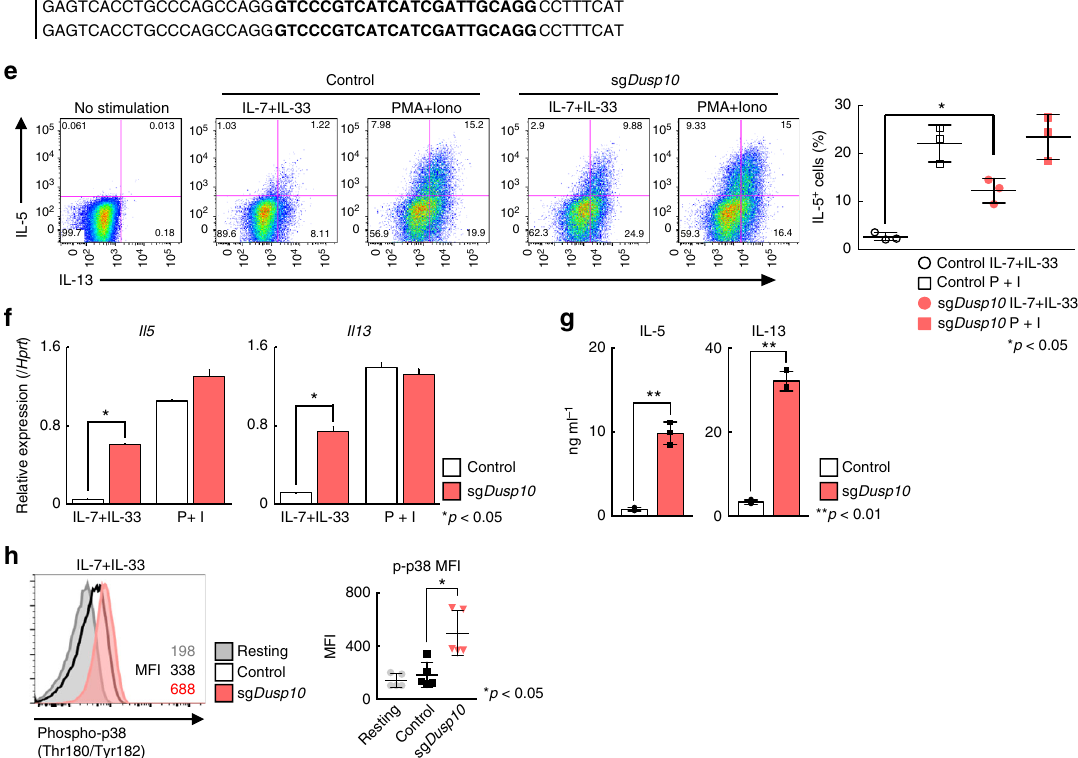
domain of DUSP10 abrogated its phosphatase activity, and (Fig. 4c, n = 3 for each group, * p < 0.05). Interestingly, the therefore we also included this mutant (C409S) form of DUSP10 Dusp10 C409S mutant did not affect cytokine production from in the assays 38 (Fig. 4a – c). We con fi rmed that the levels of cell ILC2s (Fig. 4c, far right). Similarly, mRNA expression of Il5 and surface and mRNA expression of Il1rl1 in ILC2s were not dra- Il13 in Dusp10 -overexpressing ILC2s after IL-33 stimulation were matically changed by enforced expression of Dusp10 (Supple- signi fi cantly lower than the levels detected in control and Dusp10 mentary Fig. 4b and c). Enforced expression of Dusp10 in ILC2s C409S mutant groups (Fig. 4d). Protein expression levels of IL-5 suppressed the production of IL-5 and IL-13 to similar levels as and IL-13 were also assessed by ELISA, and similar results were that observed in ILC2s treated with a p38 inhibitor, SB203580 obtained (Fig. 4e). We further demonstrated the effect of Dusp10 NATURE COMMUNICATIONS| (2018) 9:4231 |DOI: